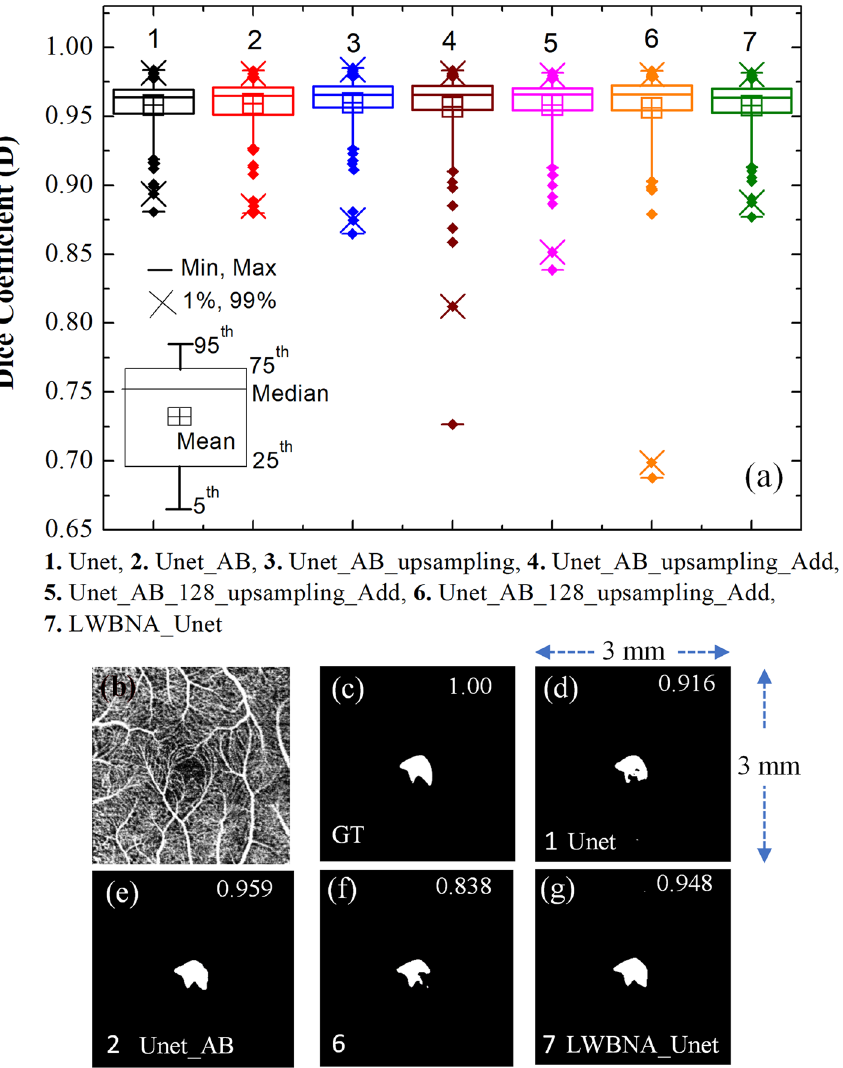
Figure 3. ( a ) Boxplot of dice coefficient (D, on a testing dataset of 145 images) obtained from the segmentation of FAZ by different DL models given in Table 1. ( b ) Relatively a clear OCTA image (3 × 3 mm 2 ) for which most of the DL models gave low D for FAZ segmentation, ( c ) ground truth (GT) image of FAZ area of ( b ), and ( d )–( f ) and ( g ) are the segmented FAZ area by DL models 1. Unet, 2. Unet_AB, 6. Unet_AB_128_upsampling_Add and 7. LWBNA_Unet,